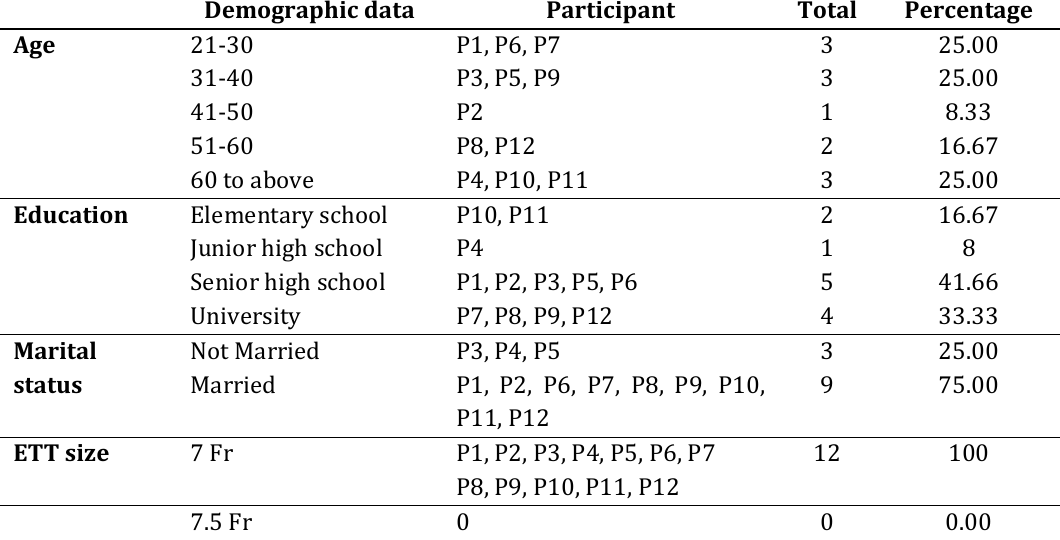
Characteristics of Respondents (n =